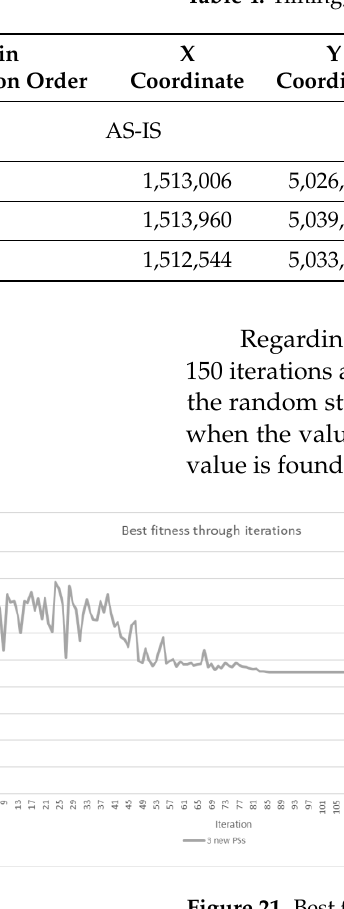
Figure 22. Output of the simulation results considering eight new PSs. Pink points are the new PSs, while gray are the existing ones. The PSs service areas are highlighted in Figure 23. The increased number of new PS allowed reducing the PS service areas dimension, giving undoubted advantages in reduc- ing the distance between squares and the related PSs. Again, the cells ’ colors show that the algorithm does not fail to find a feasible solution, which guarantees a power demand of the PSs lower than 75% of the transformer s’ nominal power. Nevertheless, several PSs have a loading greater than 50%, even with reduced values lower than the three new PSs.